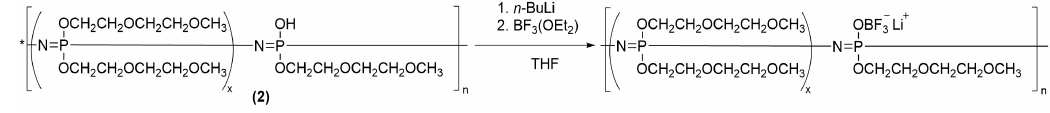
Figure 2. Last step of the synthesis of poly[bis 2(2-methoxyethoxy)ethoxy-co-oxytrifluoroborat lithium phosphazene].